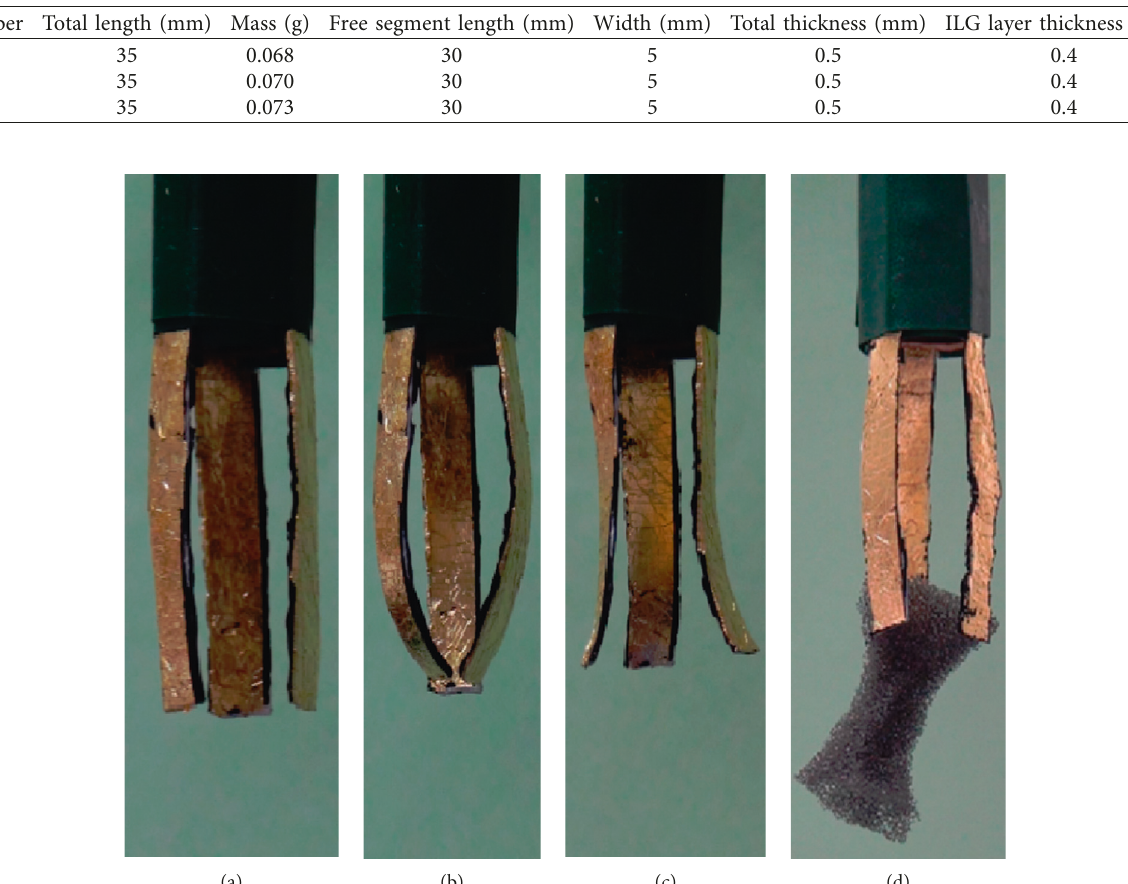
Figure 17: Screenshots of the soft robot grabbing an object. (a) Natural stretching. (b) Bending inward. (c) Bending outward. (d) Grabbing an